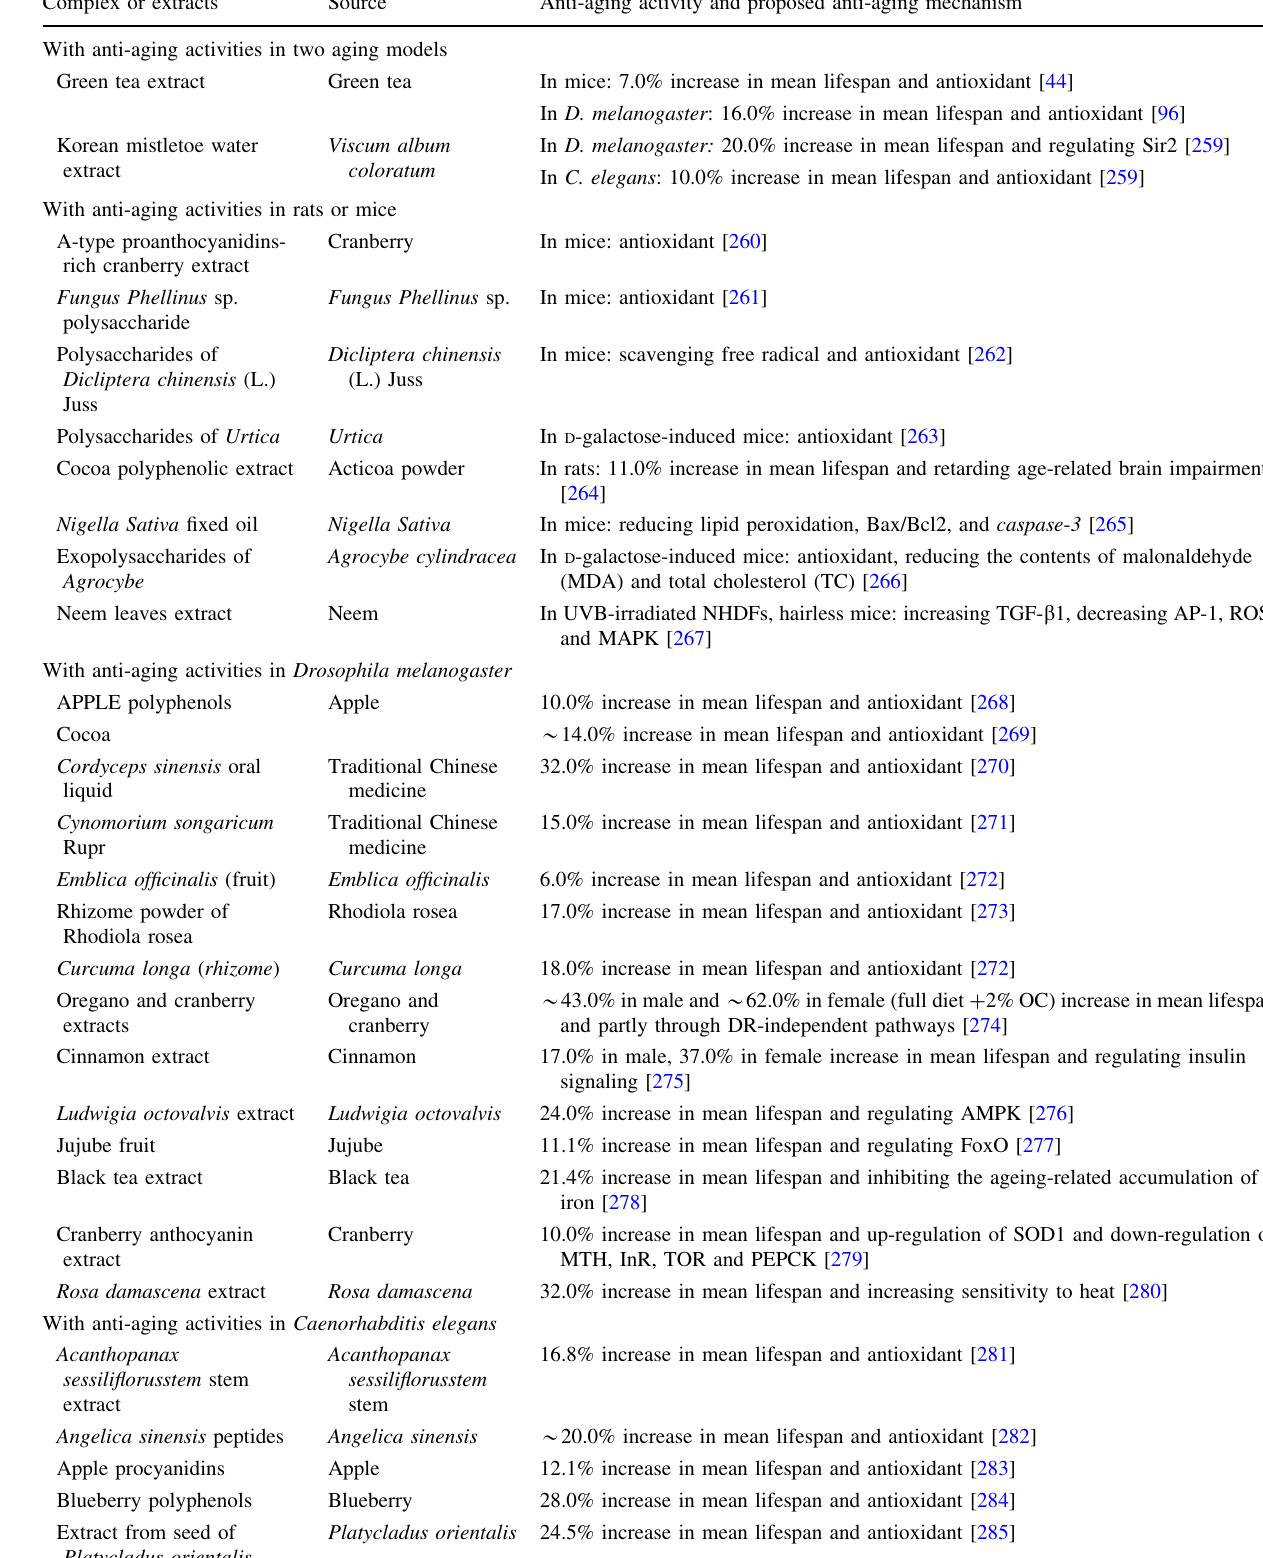
Table 2 Natural product extracts with anti-aging activities Complex or extracts With anti-aging activities in two aging